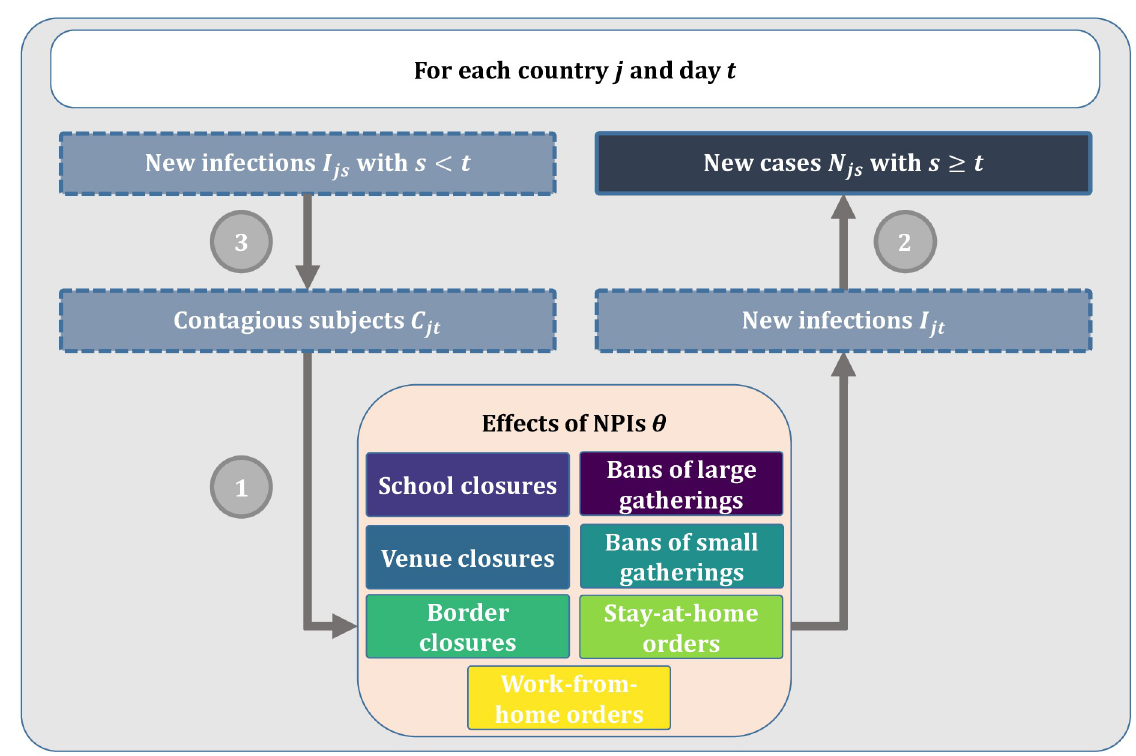
Fig 2. Visual summary of the model structure. (1) the number of new infections is modelled as a function of the number of contagious subjects, the country-specific daily transmission rate, and the reductions from active NPIs; (2) the observed number of new cases is a weighted sum of the number of new infections in the previous days; and (3) the number of contagious subjects is a weighted sum of the number of new infections in the previous days.